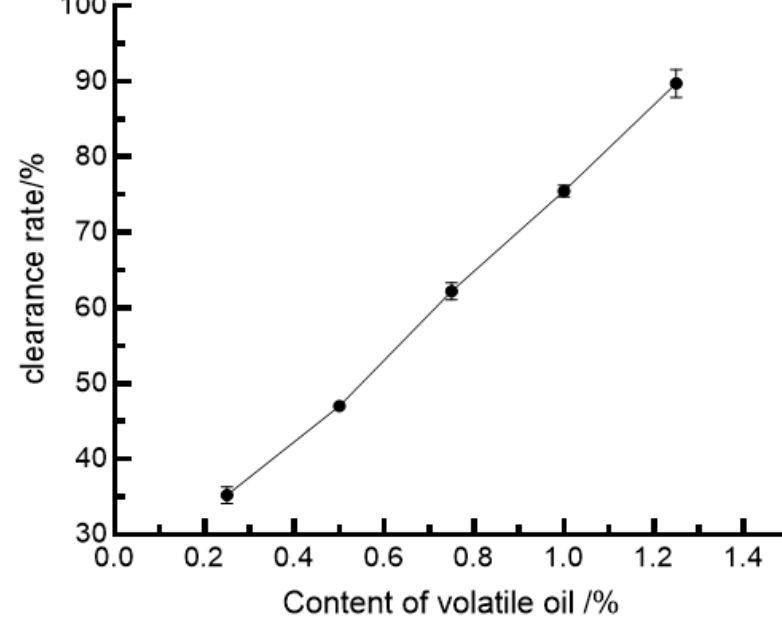
Figure 4. • OH scavenging activity of Allium tenuissimum L. flowers essential oil. Figure 4. •OH scavenging activity of Allium tenuissimum L. flowers essential oil. As shown in Figure 4, there was a positive and linear correlation between the volatile oil con‑ tent and the scavenging of hydroxyl radicals, with a regression equation of Y = 53.948X + 20.9390000 and R 2 = 0.9859, giving a 50% scavenging of hydroxyl radicals at a volatile oil concentration of